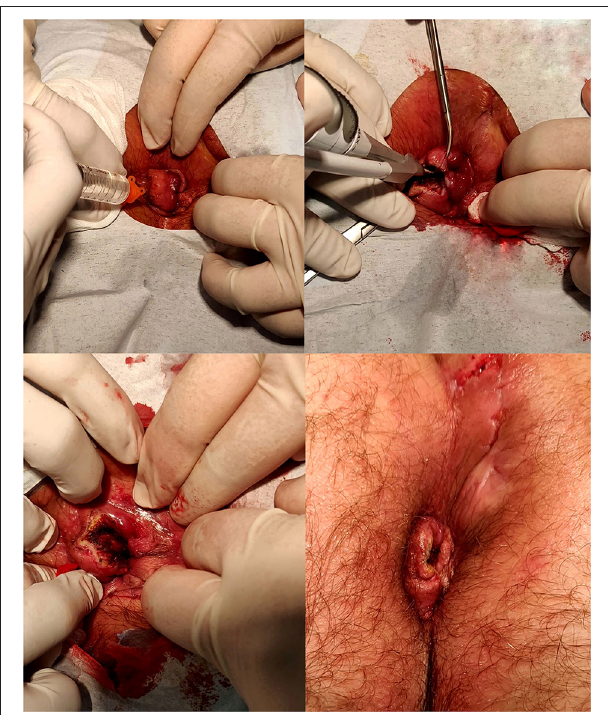
FIGURE 1 | Main steps of the surgical procedure.